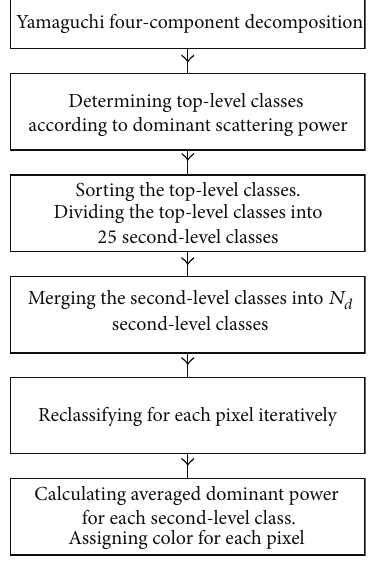
Figure 1: The flow chart of unsupervised